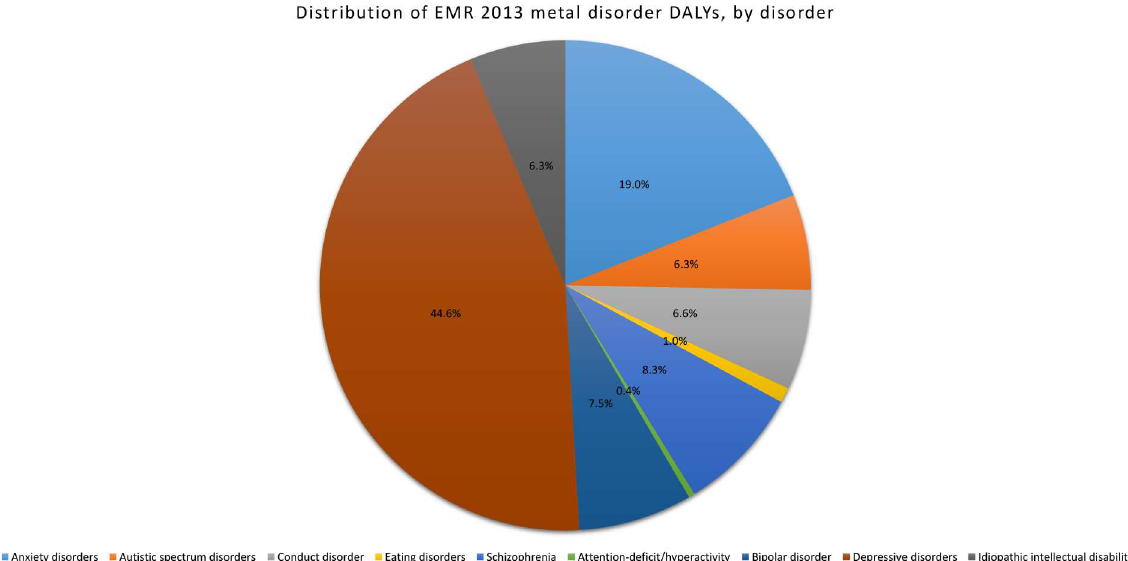
Fig 6. Proportion of DALYs explained by each mental disorder within the